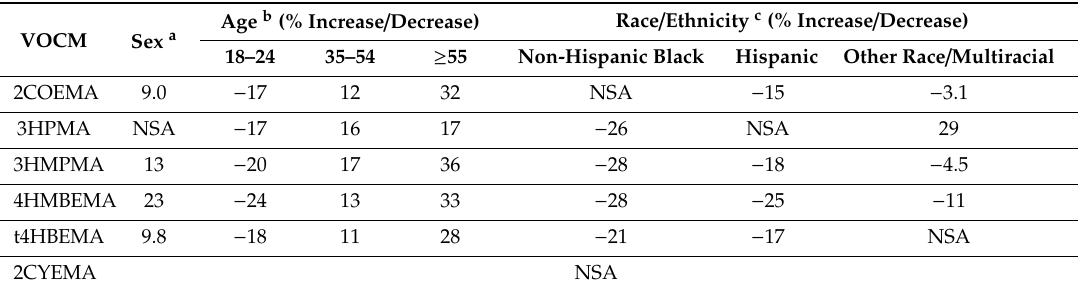
Table 3. Summary of sample-weighted multivariate regression modeling of predictor variables for six urinary VOC metabolites and selected